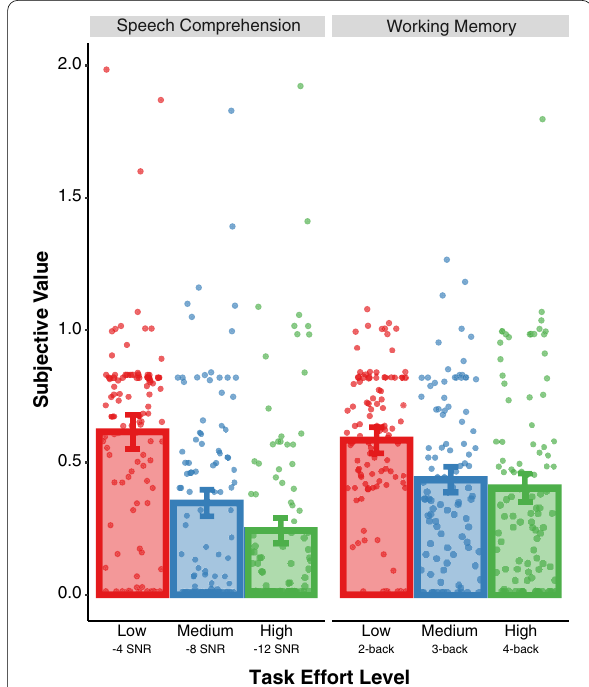
Fig. 1 Effects of task load (low effort: 2-back, effort: 3-back, 8 dB SNR; high effort: 4-back, − subjective value estimates in working memory and speech comprehension domains. Data points represent subjective value estimates for each participant. Error bars represent 95% Confidence Intervals